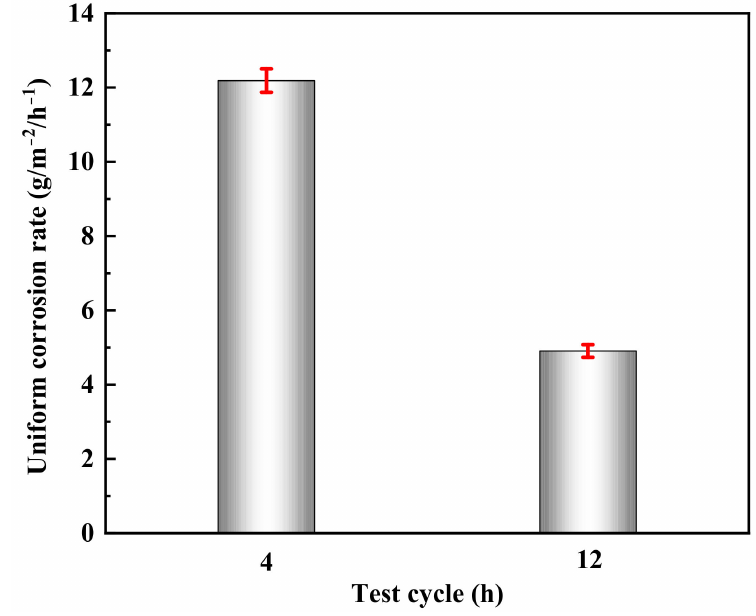
Figure 9. Uniform corrosion rate at different test